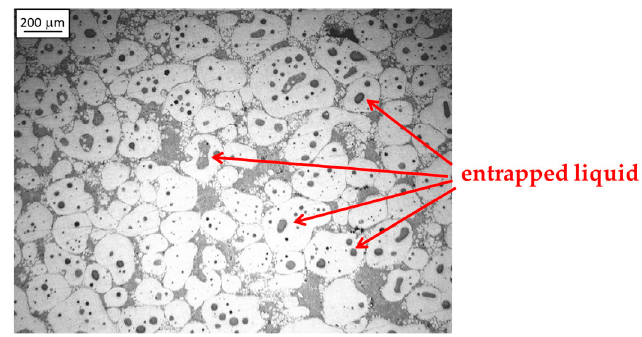
Figure 6. Thixocasting microstructure with entrapped liquid in the globules.